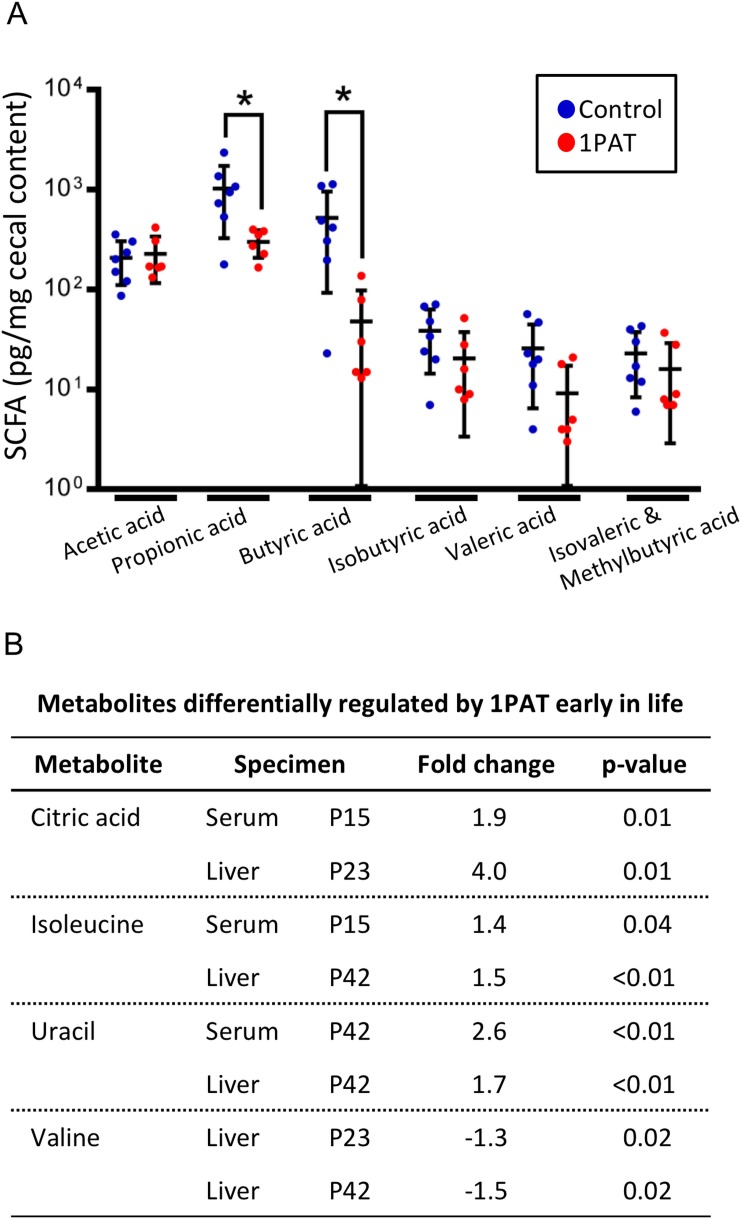
Effect of 1PAT on early-life metabolism.(A) Quantitation of six short chain fatty acids (SCFA) in P23 cecal samples. Samples were examined by targeted GC/MS; formic acid was not detectable (not shown). Groups: Control (n = 7), 1PAT(n = 6), compared by Welch’s T Test for unpaired samples (*p<0.05). (B) Hepatic and serum metabolites differentially induced by 1PAT. Analysis based on significance at ≥ 2 time points or in both serum and liver in the same direction (n = 7–17 samples per group) [See also Supplementary file 2].10.7554/eLife.37816.020Figure 3—source data 1.Values of concentrations of six short chain fatty acids.